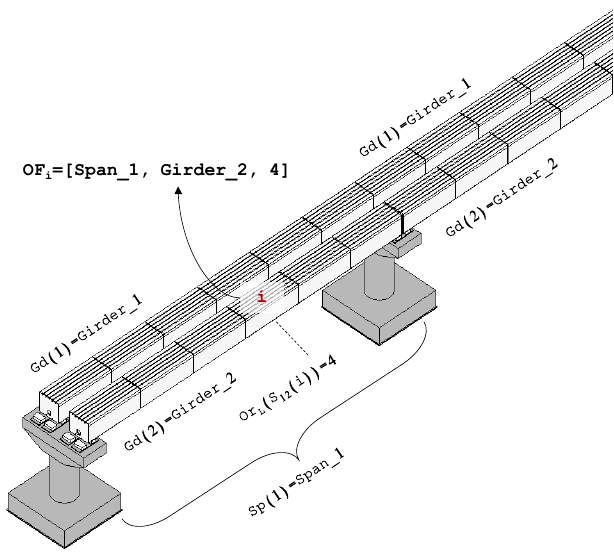
Figure 9. Examples of object feature set for a bridge model.